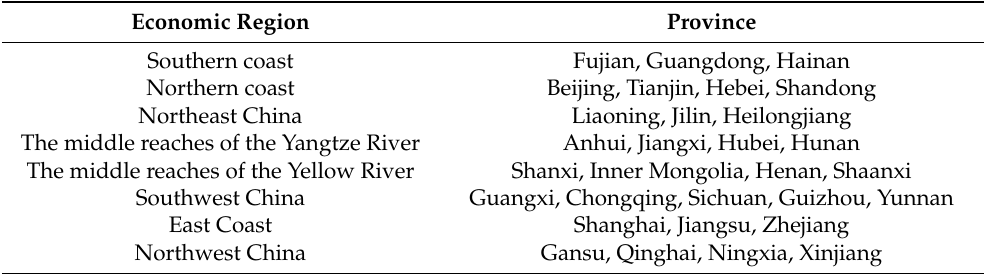
Table 3. Division of economic